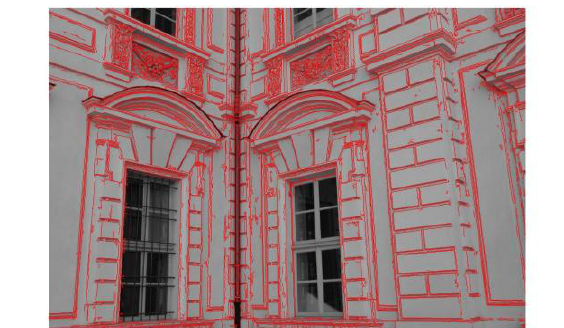
Figure 10. Extracted edges on the reference image (about 96000 dominant